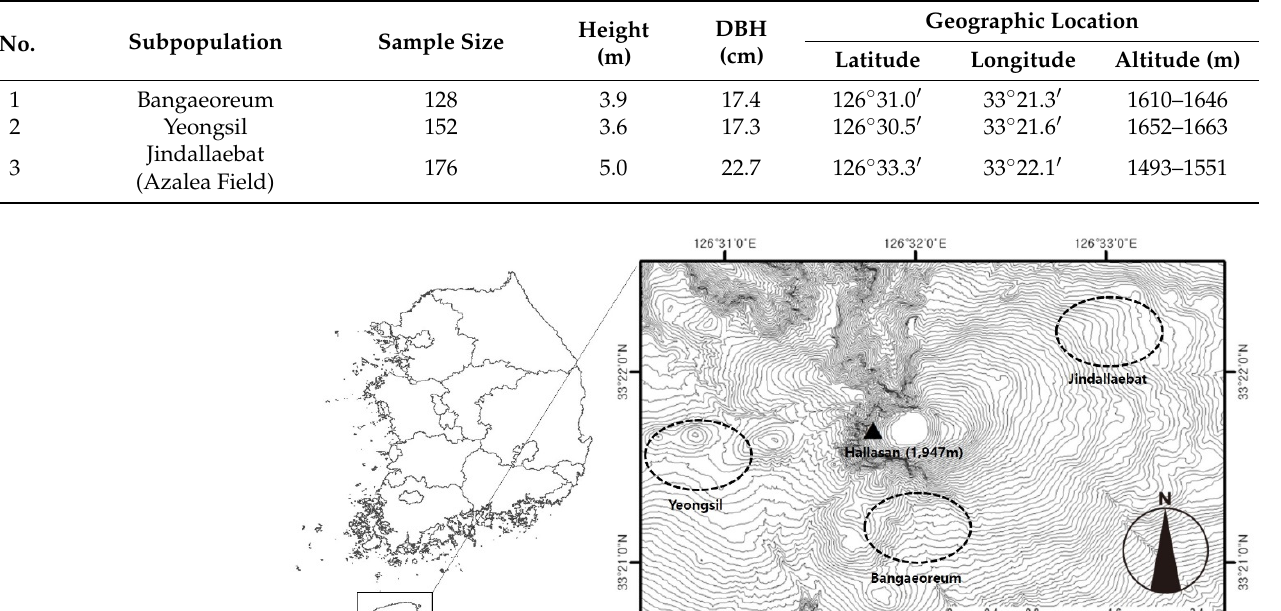
Table 1. Location of sampled Abies koreana subpopulations.